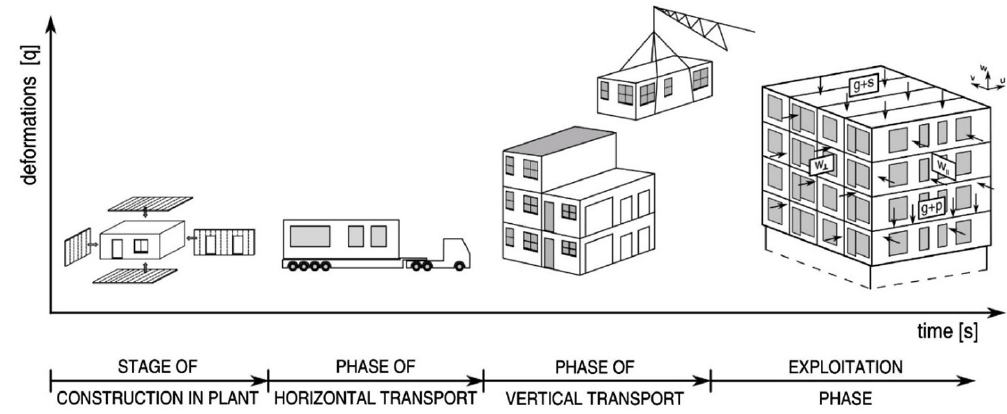
Figure 6. Stages of industrialized (in the plant) building construction